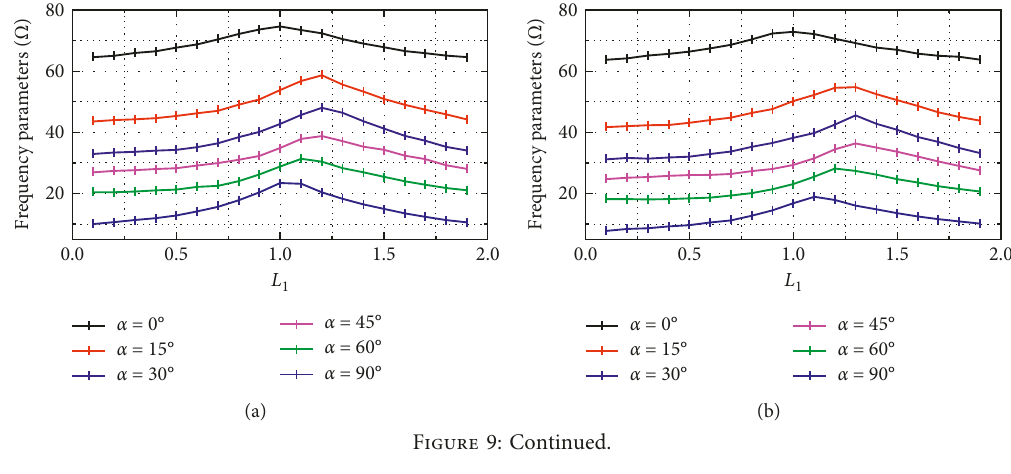
90 ° ): (a) 1st mode; (b) 2nd mode; (c) 3rd mode; (d) 4 th 1m, L / R 2, h / R 0.05, d / R 0.5, θ 1 + θ 2 (cid:31) (cid:31) (cid:31) (cid:31) (cid:31)